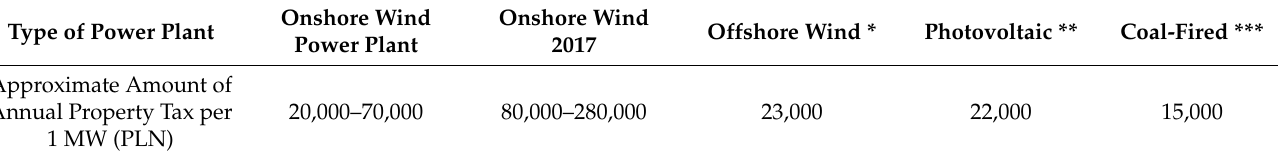
Table 1. Different amount of property tax relevant for different sources of